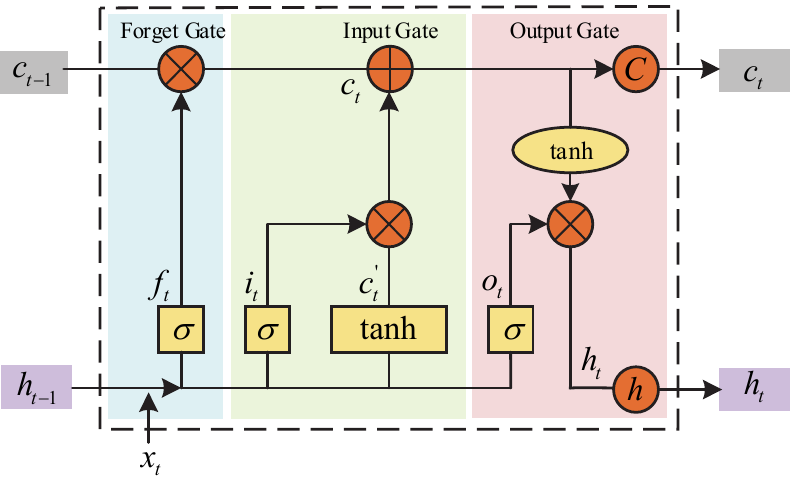
Figure 6. Long short ‐ term memory neural network.